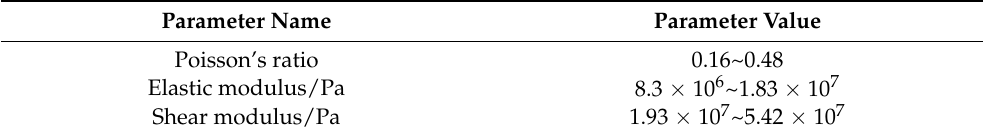
Table 3. Physical parameters of the granular fungal fertilizer.